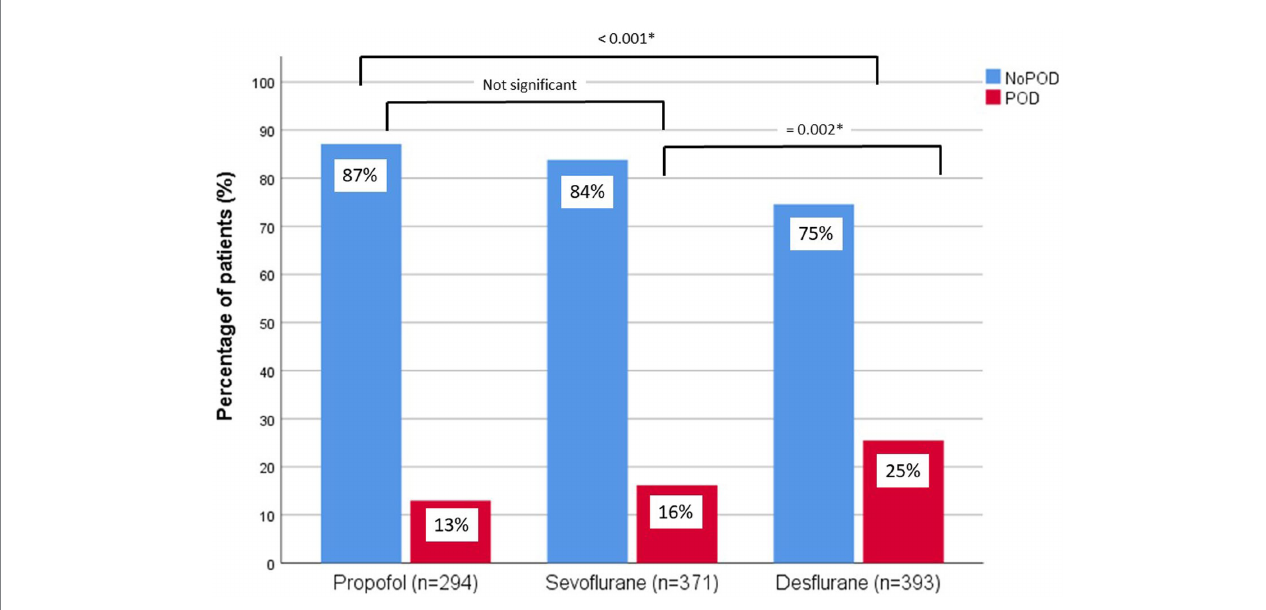
FIGURE 1 Incidence of POD and NoPOD for each anesthetic agent (propofol, sevoflurane, desflurane) in percentage of patients (%). Differences were calculated by Chi-Square test.